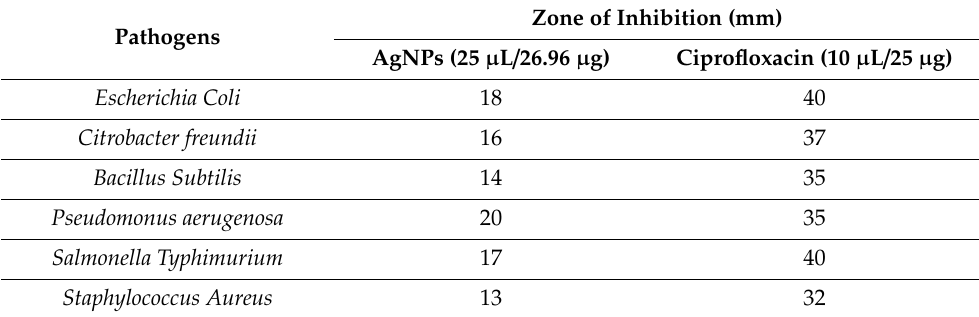
Figure 5. Photographic image of ZOI accreted by AgNPs against E.C., Escherichia coli (carsgn-2); C.F., Citrobacter freundii (JCM-1657); B.S., Bacillus subtilis (carsgp-3); P.A., Pseudomonas aeruginosa (carsgn-3); S.T., Salmonella typhimurium (JCM-1652); and S.A. Staphylococcus aureus (cars-2). Table 2. Zone of inhibition analyzed by synthesized AgNPs using Amorphophallus paeoniifolius tuber extract against six pathogenic bacteria.